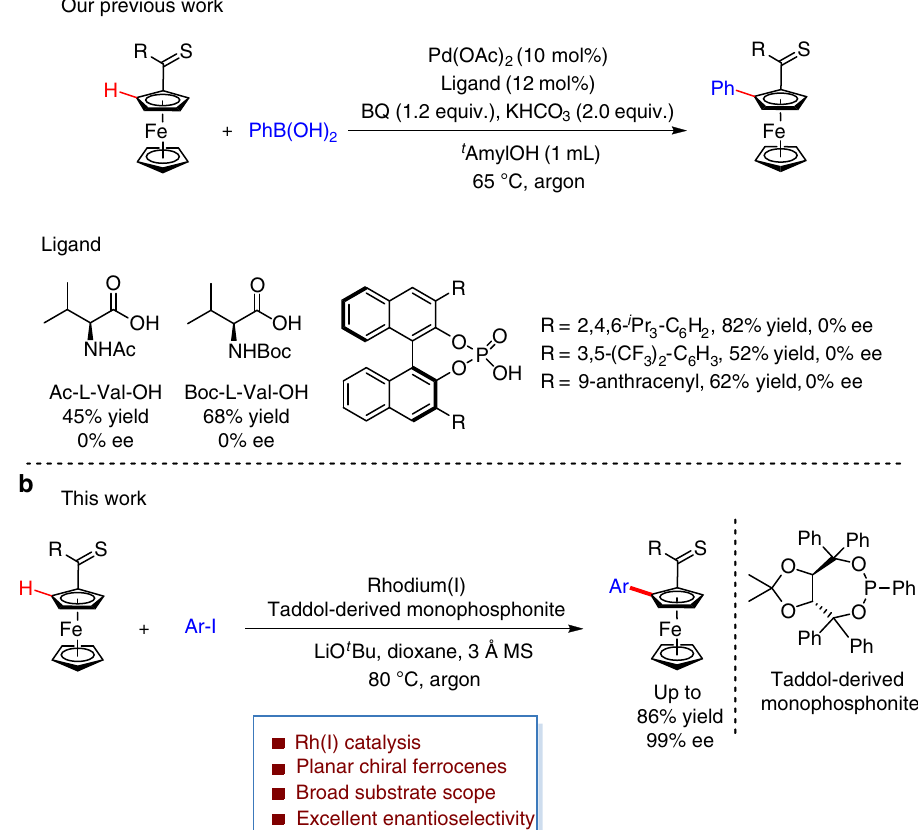
Fig. 1 Thiocarbonyl-chelation-assisted C – H bond arylations. a Failed attempts via palladium(II) catalyzed direct C – H arylation. b Enantioselective C – H arylation of ferrocenes enabled by rhodium(I) and monodentate